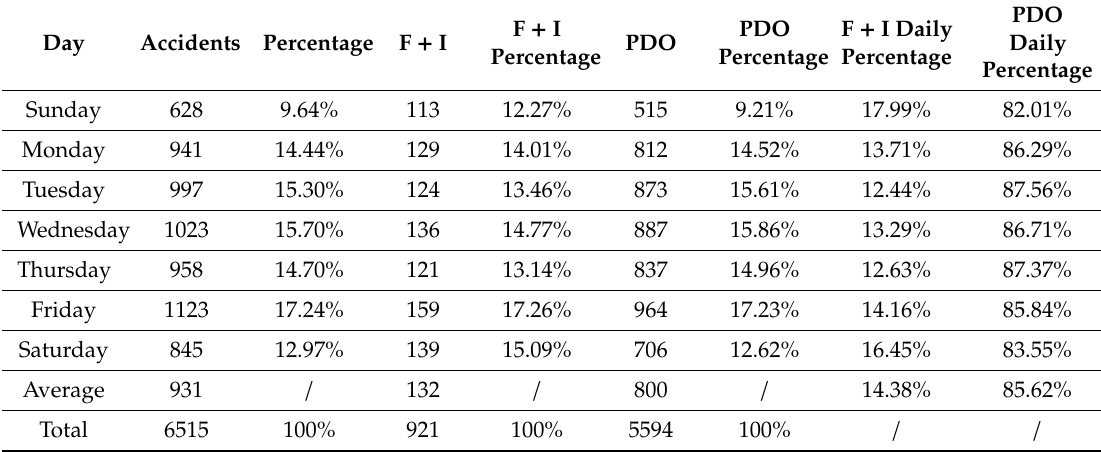
Table 9. Instances and percentages of the input factor “Day of the